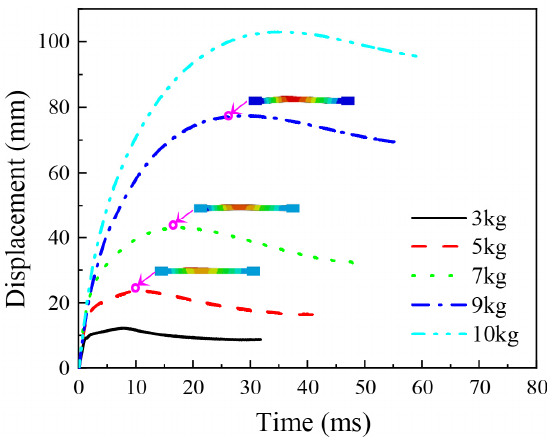
Figure 20. Displacement–time curves of the prefabricated shear wall with 10% grouting defects under